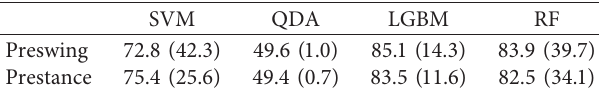
Table 2: Average accuracy and consumption time of transient-state recognition (unit: % ( ms ) ).